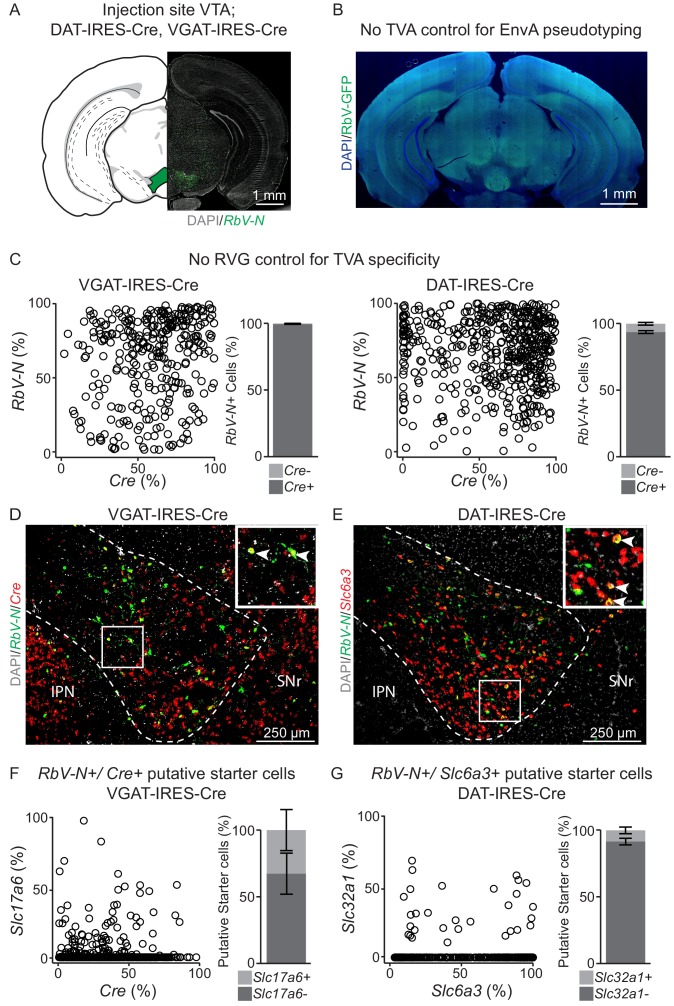
Quantification and genetic characterization of VTA starter cells from monosynaptic retrograde tracing and controls for rabies virus.(A) Left: Coronal section of injection site into VTA and starter cells location for Cre-dependent monosynaptic retrograde-tracing experiments. Right: FISH for RbV-N to demonstrate the location of rabies infected cells in the VTA. (B) Negative control for EnvA pseudotyping of the rabies virus (EnvA-RbV-GFP) showing a coronal section following injection of EnvA-RbV-GFP into the VTA without prior infection by AAV-TVA-mCh. Without co injecting AAV-DIO-TVA-mCh, EnvA-RbV-GFP cannot infect neurons, thus no GFP expression. (C) Controls for specificity of starter cell populations. EnvA-RbV-GFP was injected into the VTA of VGAT-IRES-Cre (left) and DAT-IRES-Cre (right) mice following injection of AAV-DIO-TVA-mCh, but not AAV-DIO-RVG. Therefore, rabies virus could not spread from initially infected neurons. Left: Quantification of fluorescence coverage of RbV-N+ cells in VGAT-IRES-Cre mice, almost all (99%) infected cells expressed detectable levels of Cre demonstrating specificity of the AAV-DIO-TVA virus (n = 319 cells, two mice). Right: Quantification of fluorescence coverage of RbV-N+ cells in DAT-IRES-Cre mice, almost all infected cells (95%) expressed detectable levels of Cre demonstrating specificity of the AAV-DIO-TVA virus (n = 522 cells, two mice). (D) Sample VTA FISH image of starter cell location for monosynaptic retrograde tracing experiments performed in VGAT-IRES-Cre mice. Inset depicts two putative starter cells (arrowheads) that express RbV-N (green) and Cre (red). VTA is outlined by white dashed line. (E) Sample VTA FISH image of starter cell location for monosynaptic retrograde tracing experiments performed in DAT-IRES-Cre mice. Inset depicts three putative starter cells (arrowheads) that express RbV-N (green) and Cre (red). VTA is outlined by white dashed line. (F) Left: Quantification of fluorescence coverage of single putative starter cells (Cre+ and RbV-N+) for FISH of Cre and Slc17a6 in VTA neurons of the VGAT-IRES-Cre animals (n = 567 cells, four mice). Right: The proportion of putative starter cells that expressed Slc17a6. There is a subset of VGAT-IRES-Cre+ neurons in the VTA that co-express Slc17a6 (Root et al., 2014). (G) Left: Quantification of fluorescence coverage of single putative starter cells (Slc6a3+ and RbV-N+) for FISH of Slc6a3 and Slc32a1 in VTA neurons of the DAT-IRES-Cre animals (n = 566 cells, three mice). Right: The proportion of putative starter cells that expressed Slc32a1. Note: Approximately 12% (451/3754 cells/4 mice) of Slc32a1+ VTA neurons were starter cells in VGAT-IRES-Cre retrograde labeling experiments. In DAT-IRES-Cre experiments, approximately 18% (468/2598 cells/3 mice) of Slc6a3+ VTA neurons were starter cells. Filled rectangles represent the mean and error bars are ± SEM, Abbreviations: IPN - interpeduncular nucleus, SNr – substantia nigra reticulata.